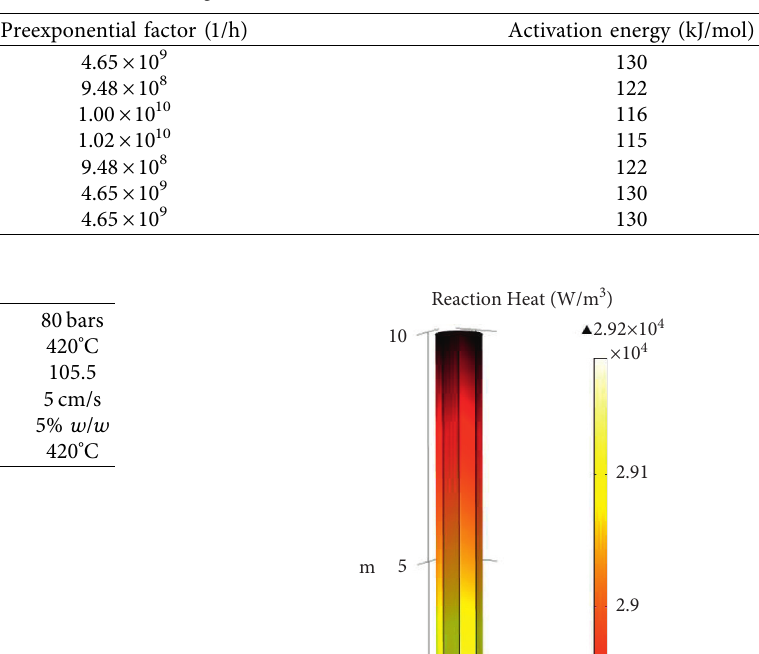
Table 3: Preexponential factors and activation energies for each reaction rate coefficient.